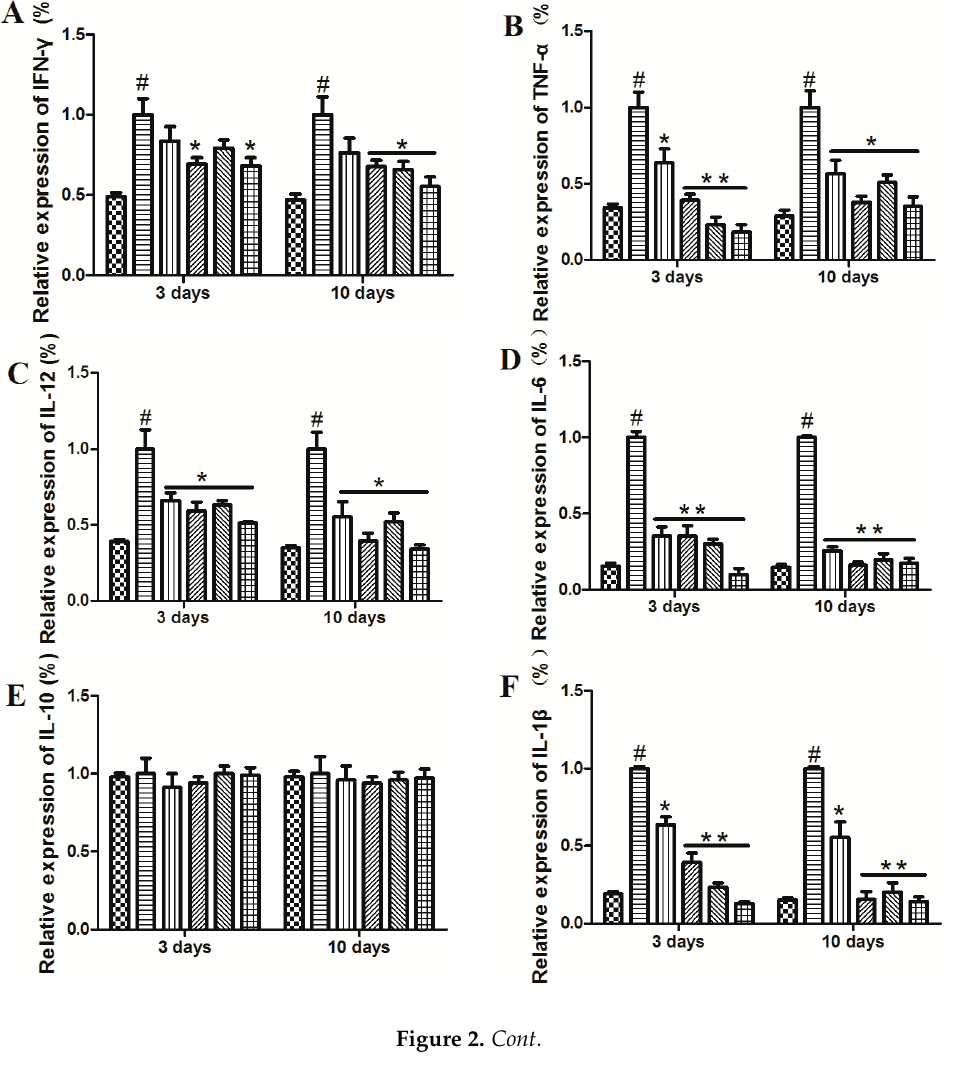
Figure 3. Cont. Figure 2. Cont